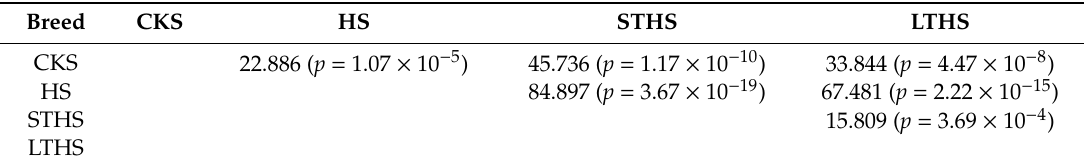
Table 3. The chi-square test of CNV types among Chinese sheep breeds.